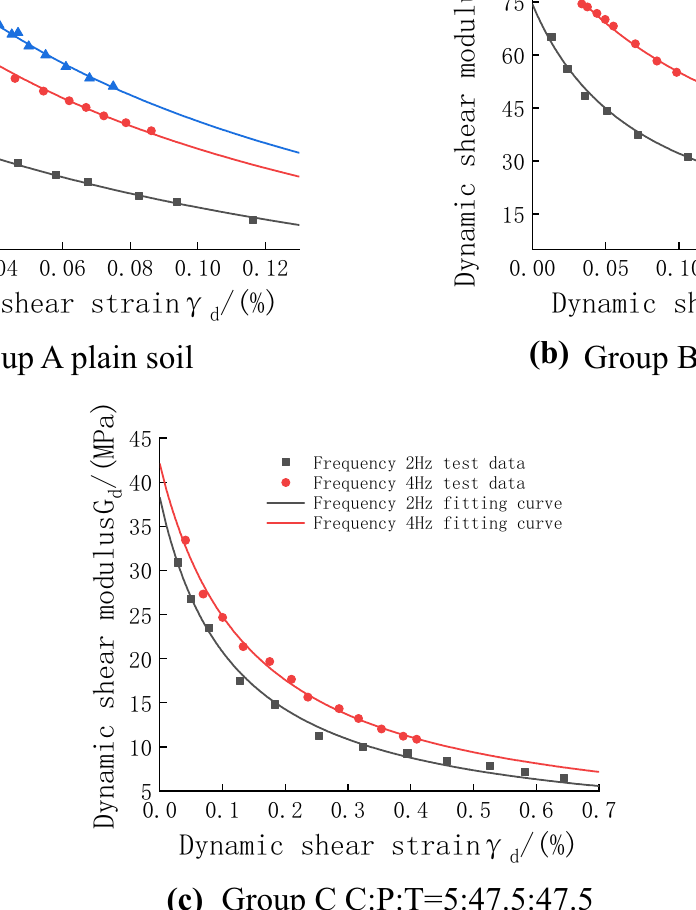
Fig. 11 Relationship between dynamic shear modulus and dynamic shear strain of phosphogypsum stabilized soil under different vibration frequencies